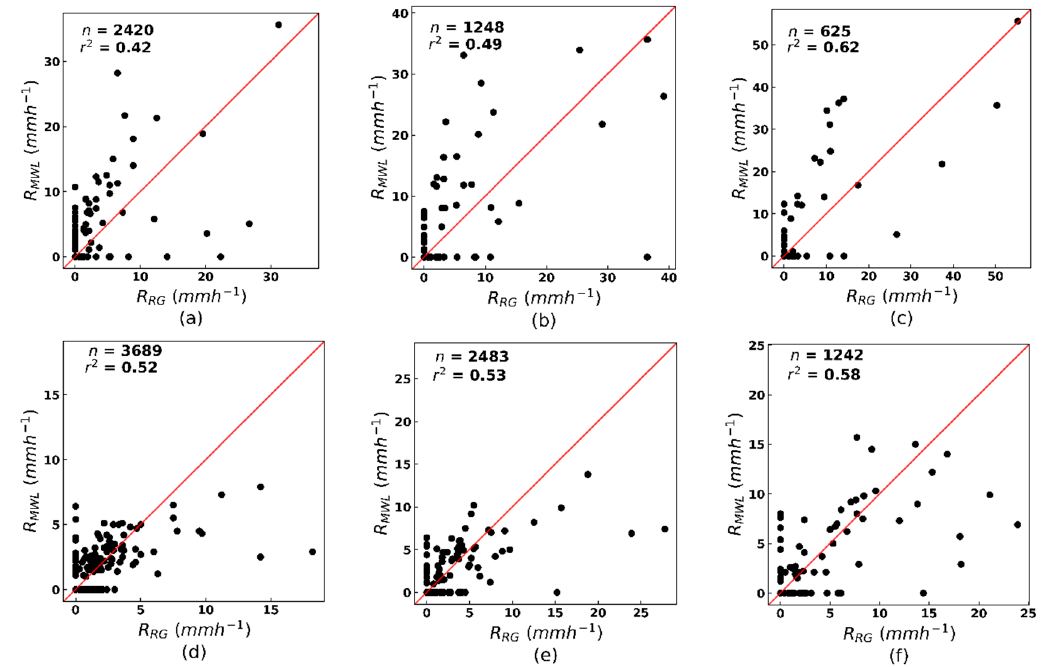
Figure 4. Scatter plot comparison of R MWL and the R RG for Kericho ( a – c ) and Naivasha ( d – f ) at 15 min ( a , d ), half-hourly ( b , e ) and hourly ( c , f ) timestamp. Table 4. Performance measures calculated from R MWL and R RG pairs from the two study locations. Study Location